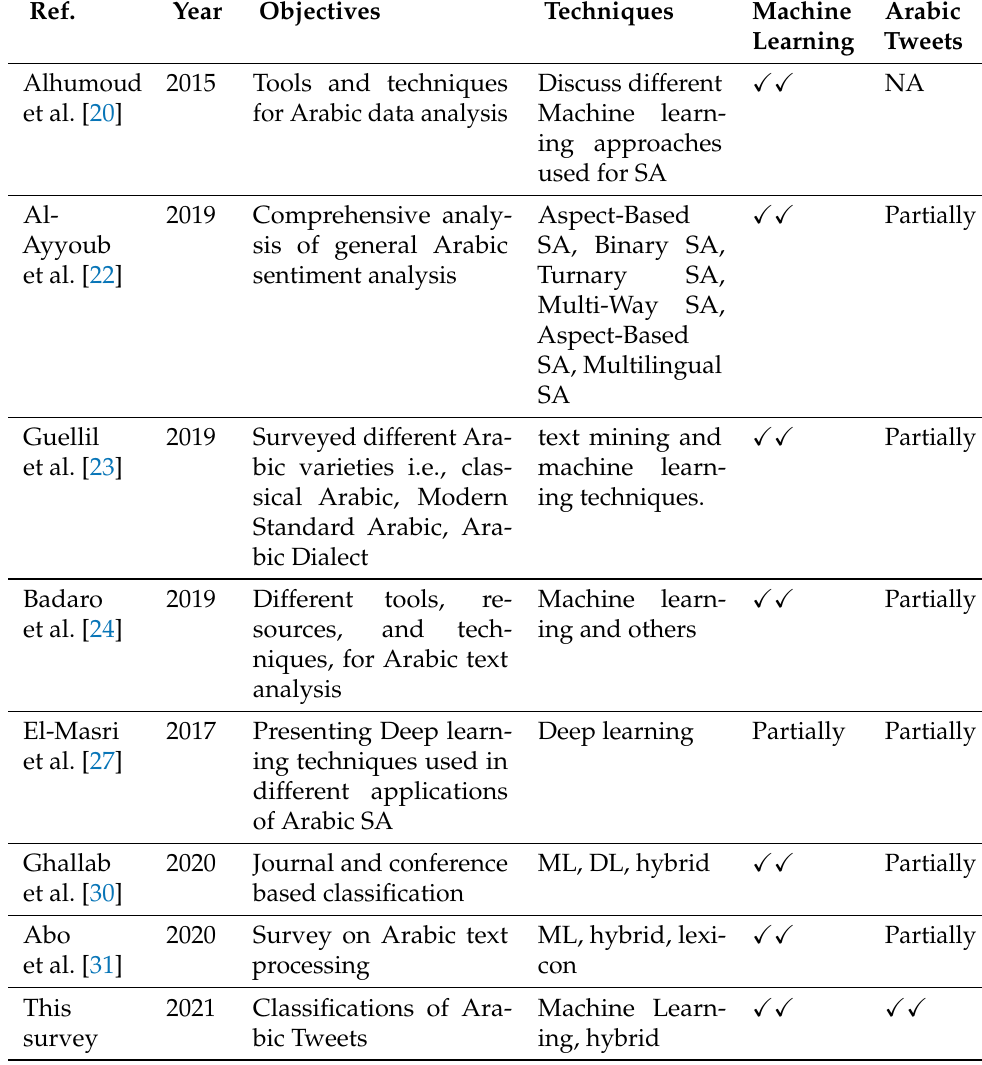
Table 1. Comparison of surveys on Arabic text